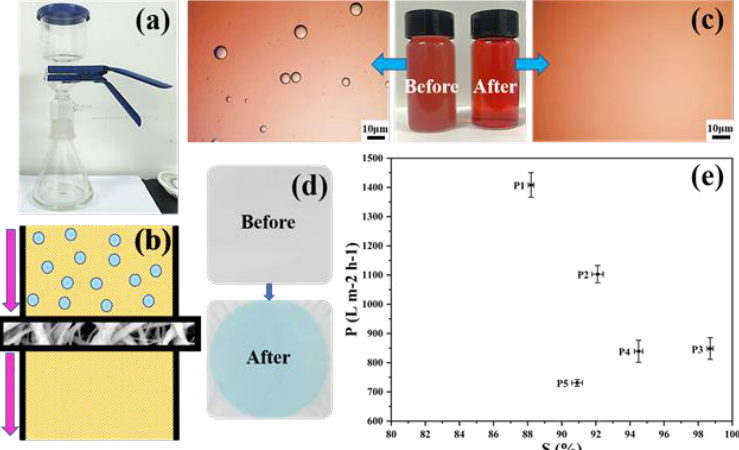
Figure 8. Oil – water separation capacity of membranes. ( a ) The device of the oil – water separation. ( b ) Schematic diagram of the oil – water separation. ( c ) Comparison of water-in-oil emulsions before and after separation. ( d ) Changes in the membrane surface before and after separation. ( e ) Separation efficiency and flux of membranes for water-in-oil emulsions.